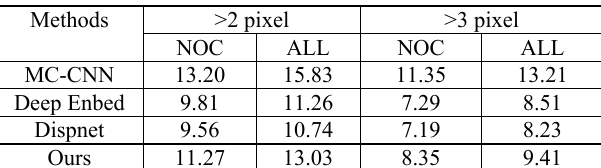
Table 2. The comparison